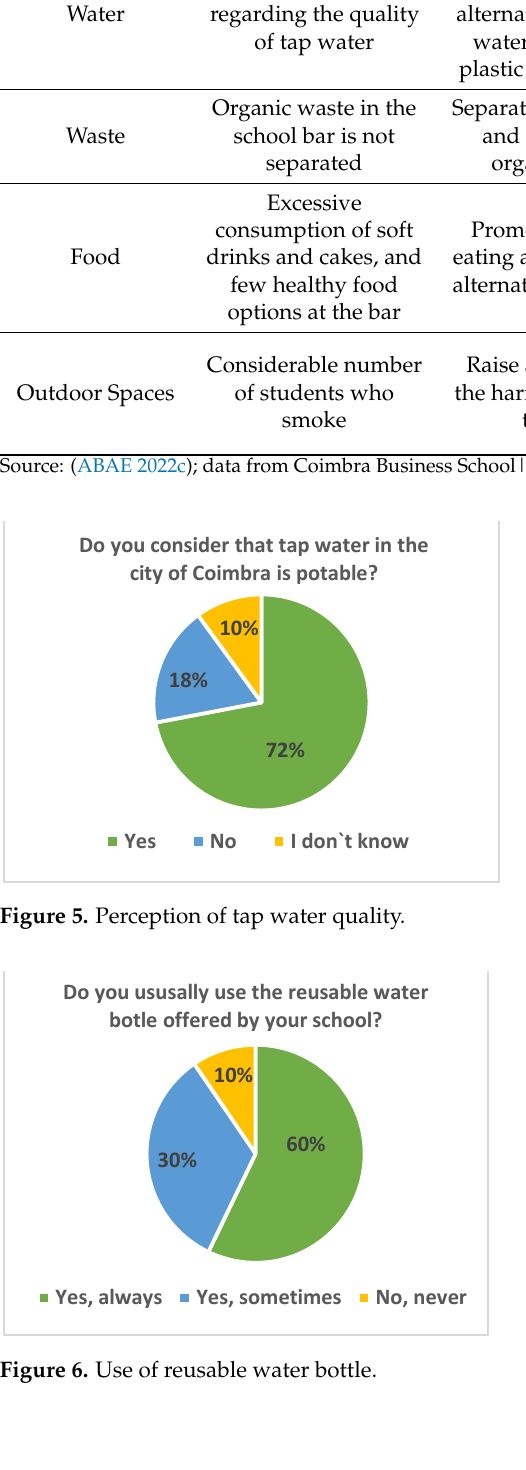
Figure 7. Impact of drinking fountains. The following step refers to the curriculum work. Besides increasing the status of the program, linking the Eco-School activities to the curriculum ensures that the Eco-School is truly integrated within the community. As already mentioned, Coimbra Business School|ISCAC is a HEI in the area of business, accounting and administration. Although the degrees, postgraduates and masters, are in scientific areas with no obvious links with the environment and sustainability, there are already several academic units of these courses that have integrated themes related to the environment and sustainability in their curricula, maintaining a close connection with the different activities promoted by the Eco-Schools program. The sixth step “inform and involve” is very important . In fact, the actions carried out within the scope of the Eco-Schools program should not be limited only to the school com- munity (students, teachers, and staff), but to the entire surrounding community (family, friends, neighbors, colleagues, etc.). As such, throughout the 2021/22 school year, the school promoted several initiatives on environment and sustainability open to the entire community, namely lectures, social media posts, art exhibitions, photography contests, and used book exchanges. In fact, it is very important that students acquire knowledge and adopt more sustainable behaviors, but even more important is its dissemination throughout society, making it more environmentally friendly and sustainable. The last step of the methodology consists of producing an Eco-Code, which is mainly a statement that represents the school ’ s commitment to sustainability. In the case of Coim- bra Business School|ISCAC, this school defined 8 key statements: ( i) “Save the environ- ment, don ’t throw trash on the floor!”; (ii) “Preserve nature, preserve your future!”; (iii) “Plastic is going around the World, let ’s end plastic!”; (iv) “Let’ s save water so Planet Earth doesn ’t dry up!”; (v) “ Washing your hands is very important, but don ’ t leave the